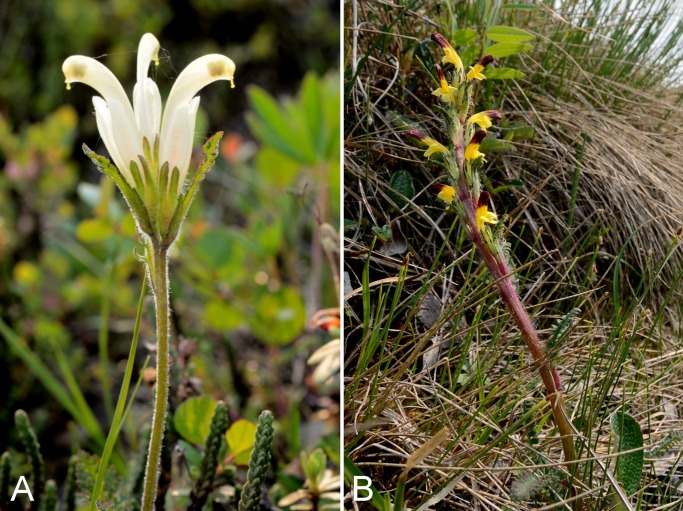
Pedicularis capitata and Pedicularis flammea.Pedicularis capitata: (A) habit, Saarela et al. 3924. Pedicularis flammea: (B) habit, Saarela et al. 3242. Photographs by R. D. Bull.